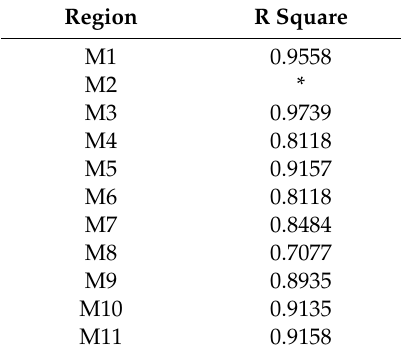
Table 2. Second-order regression adjustment of the middle region through visible interferogram.